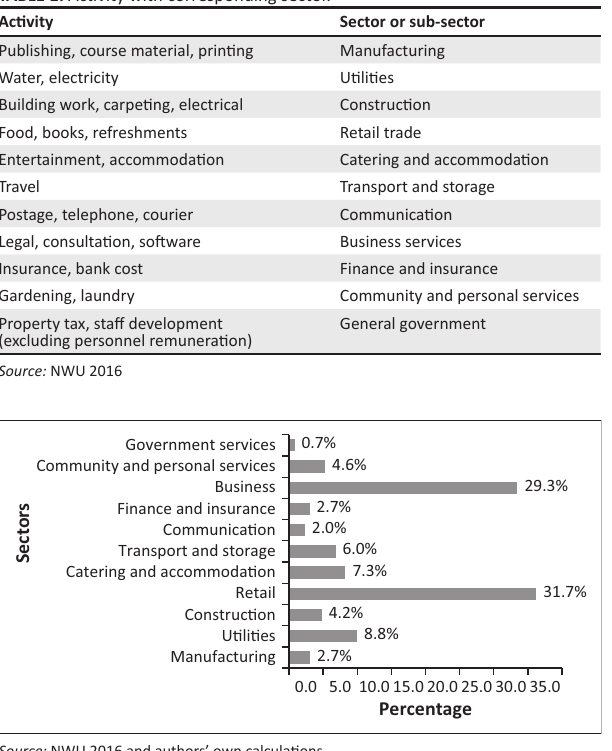
FIGURE 6 Sectors that benefit, percentage share, 2015. Salaries are